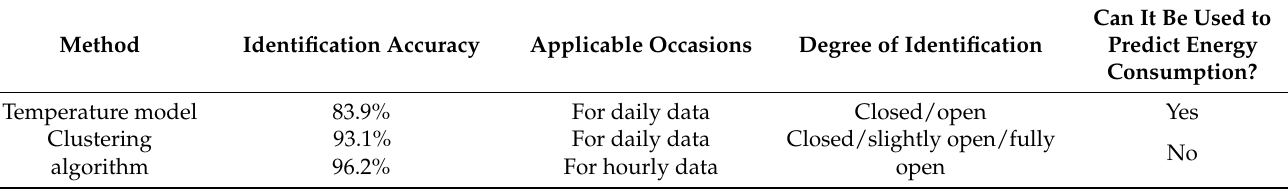
Table 4. Comparison of the OATPM and KNN